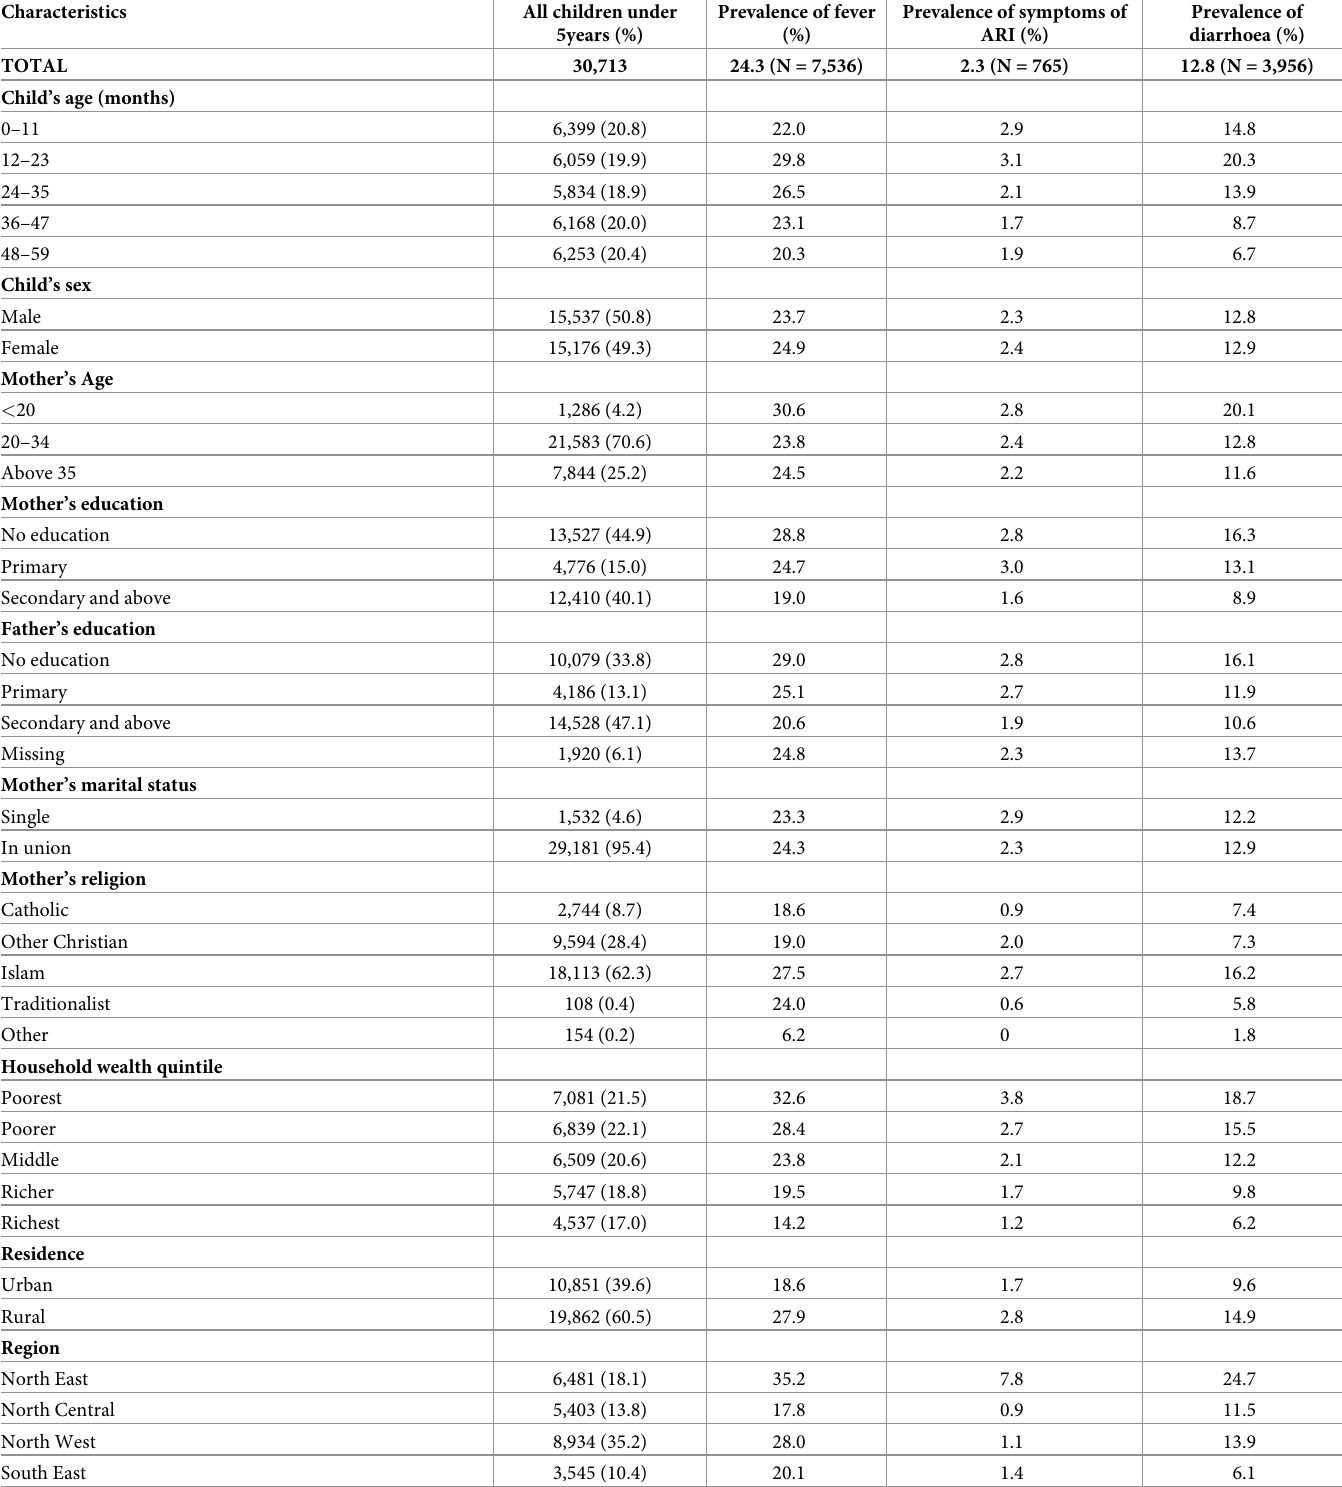
Table 1. Socioeconomic and demographic characteristics of children under 5 and prevalence of fever, diarrhoea and symptoms of acute respiratory infection (ARI) during the two weeks preceding the survey.